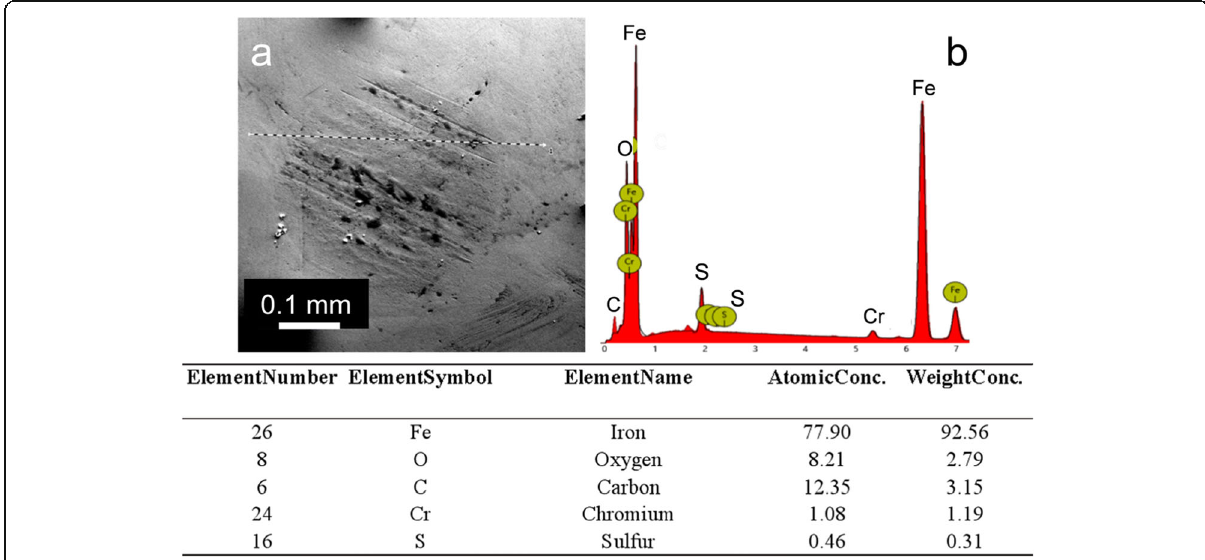
Fig. 10 The SEM image ( a ) and EDS elemental analysis ( b , the integration results of the line scanning shown in a which is marked as a dash line) of the wear scar while the SA-GO (prepared by sulfur-doped GO and octylamine; the oxidation time of the GO is 24 h and the concentration of SA-GO is 0.025 wt%) acted as lubricant additive in the 928 lubrication oil